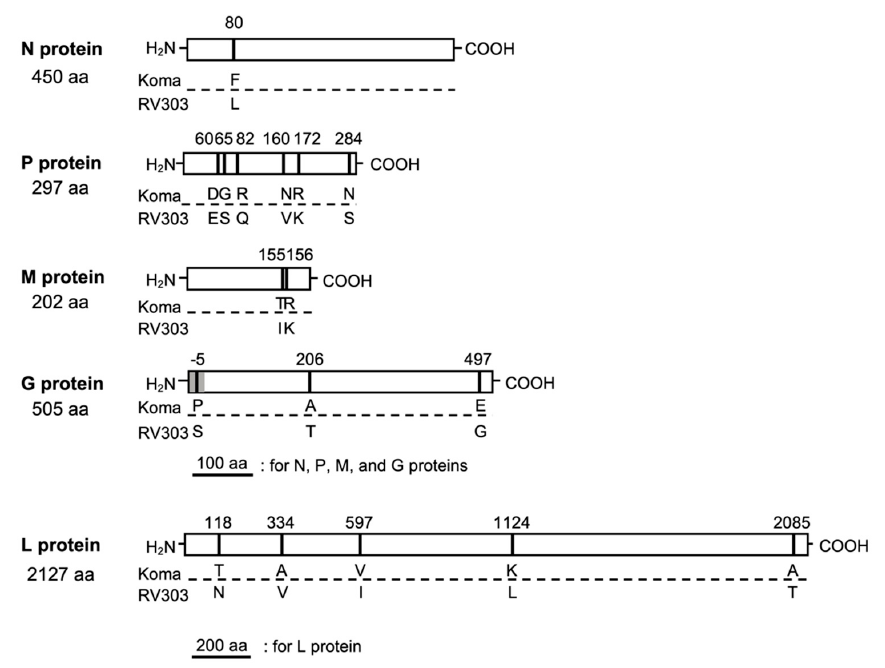
Figure 3. Amino acid substitutions in N, P, M, G, and L proteins between Koma and RV303. Vertical bars with numbers on each protein indicate positions of the substitutions. Amino acid residues of the Koma strain (upper) and RV303 strain (lower) at the substitution sites are shown as a single letter code. The amino acid number in the G protein is assigned to the mature form that does not contain an N ‐ terminal signal peptide of 19 aa (shaded).